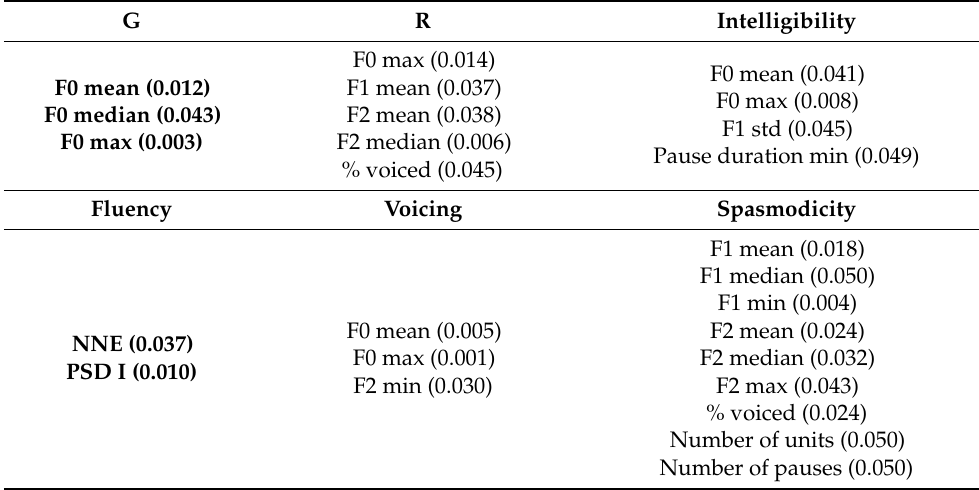
Table 8. Statistical analysis results of the first AI experiment. The p -values are reported in